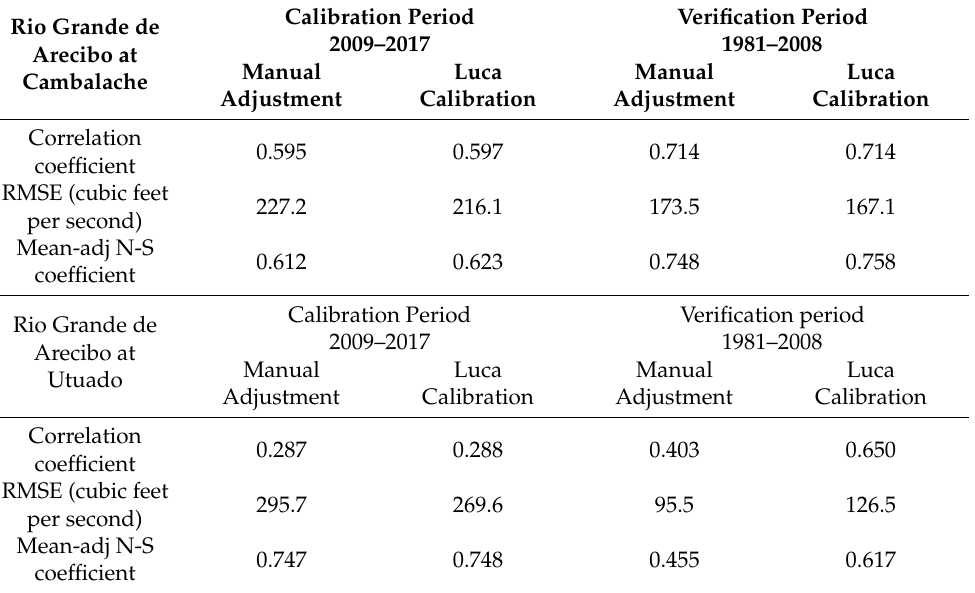
Table 6. Statistics of streamflow for the manual calibration and completed four-step Luca calibration; N-S: Nash–Sutcliffe; RMSE: root mean square